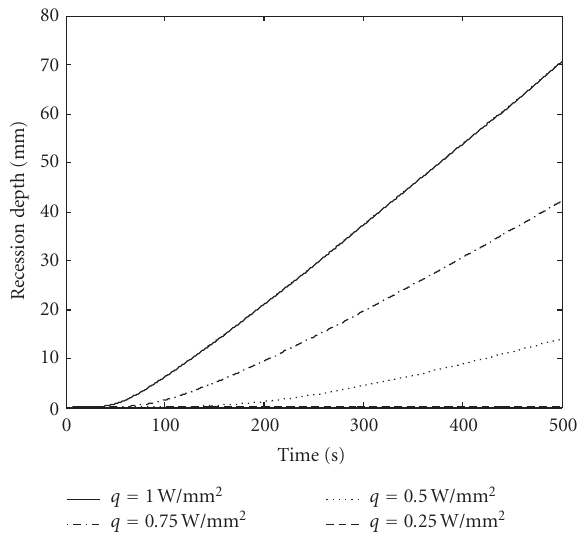
Figure 7: Surface recession with time at sea level, h = 0.